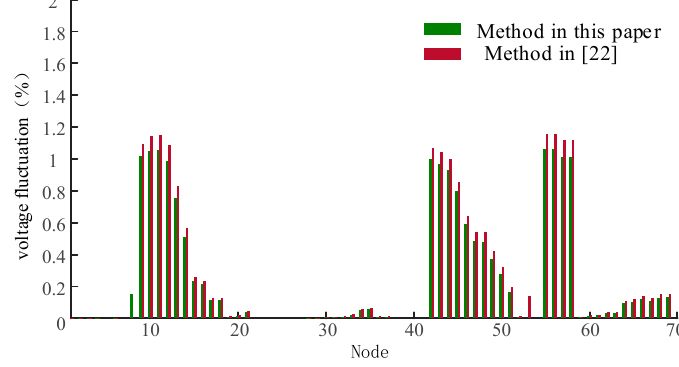
Figure 9. Comparison of voltage fluctuations at power supply-restored nodes.